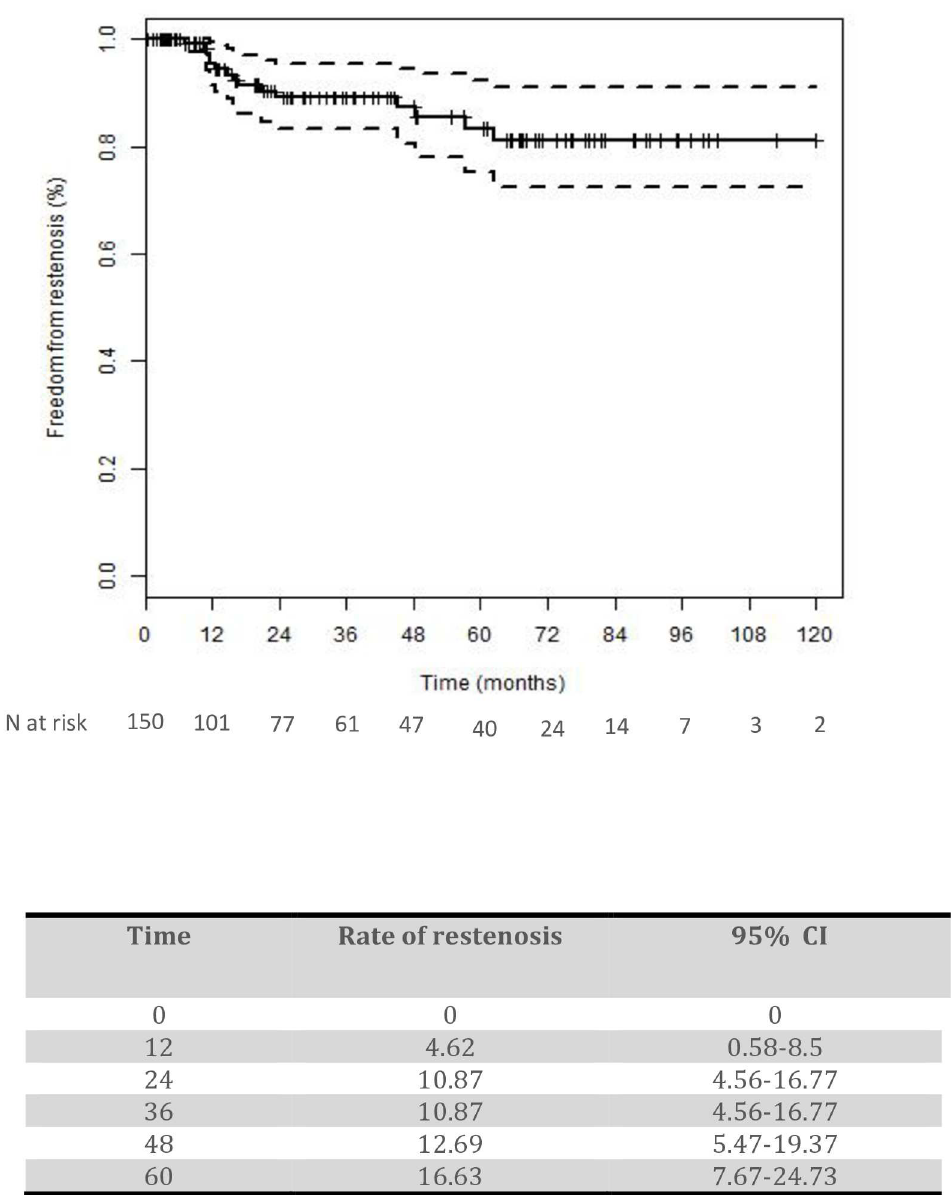
Fig 3. probabilityof in-stentrestenosis or occlusion. Kaplan-Meier